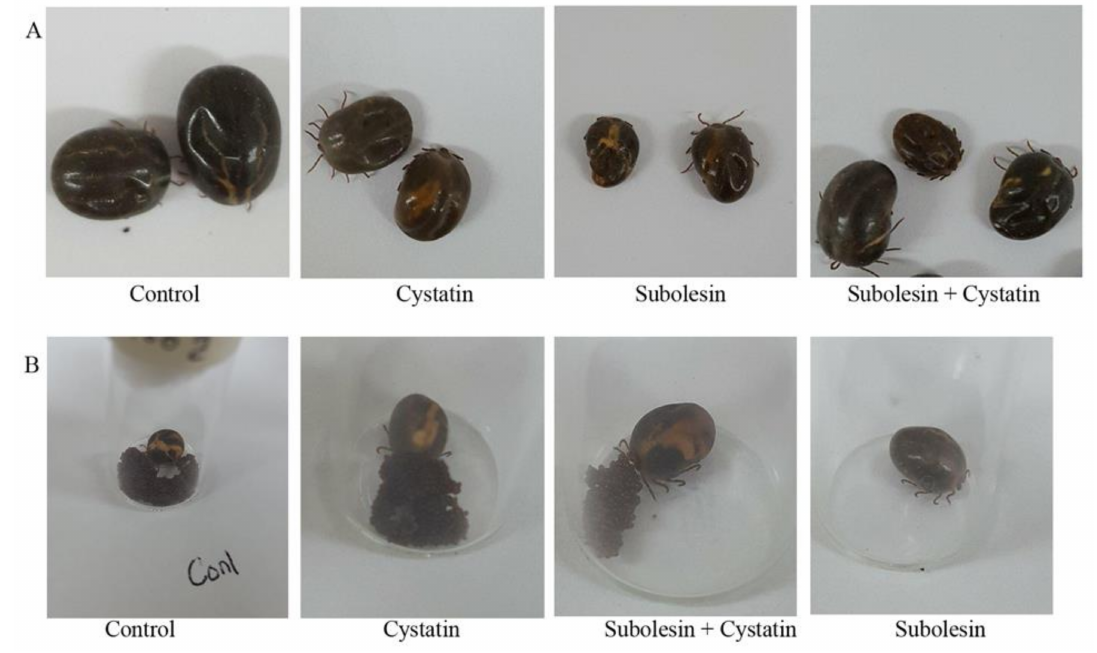
Figure 6. Phenotypic changes of tick engorgement ( A ) and egg masses ( B ). Cystatin, subolesin, and a mixture of subolesin + cystatin ds RNA were injected into unfed female ticks. The control group was injected with an injection buffer. The injected ticks were fed alongside an equal number of males, up to spontaneous